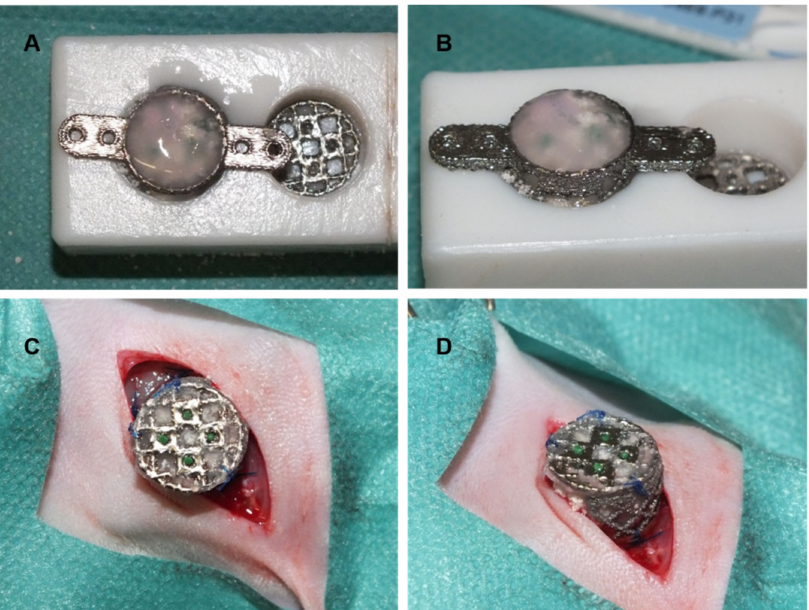
Figure 1. Implantation of chambers into donor animals. The chamber was filled with hydroxyapatite scaffold and fibrin sealant with or without rhBMP-2/mesenchymal stem cells after osteogenic differentiation ( A , B ). Afterward, the chamber was secured to the muscles in the medial femoral region ( C , D